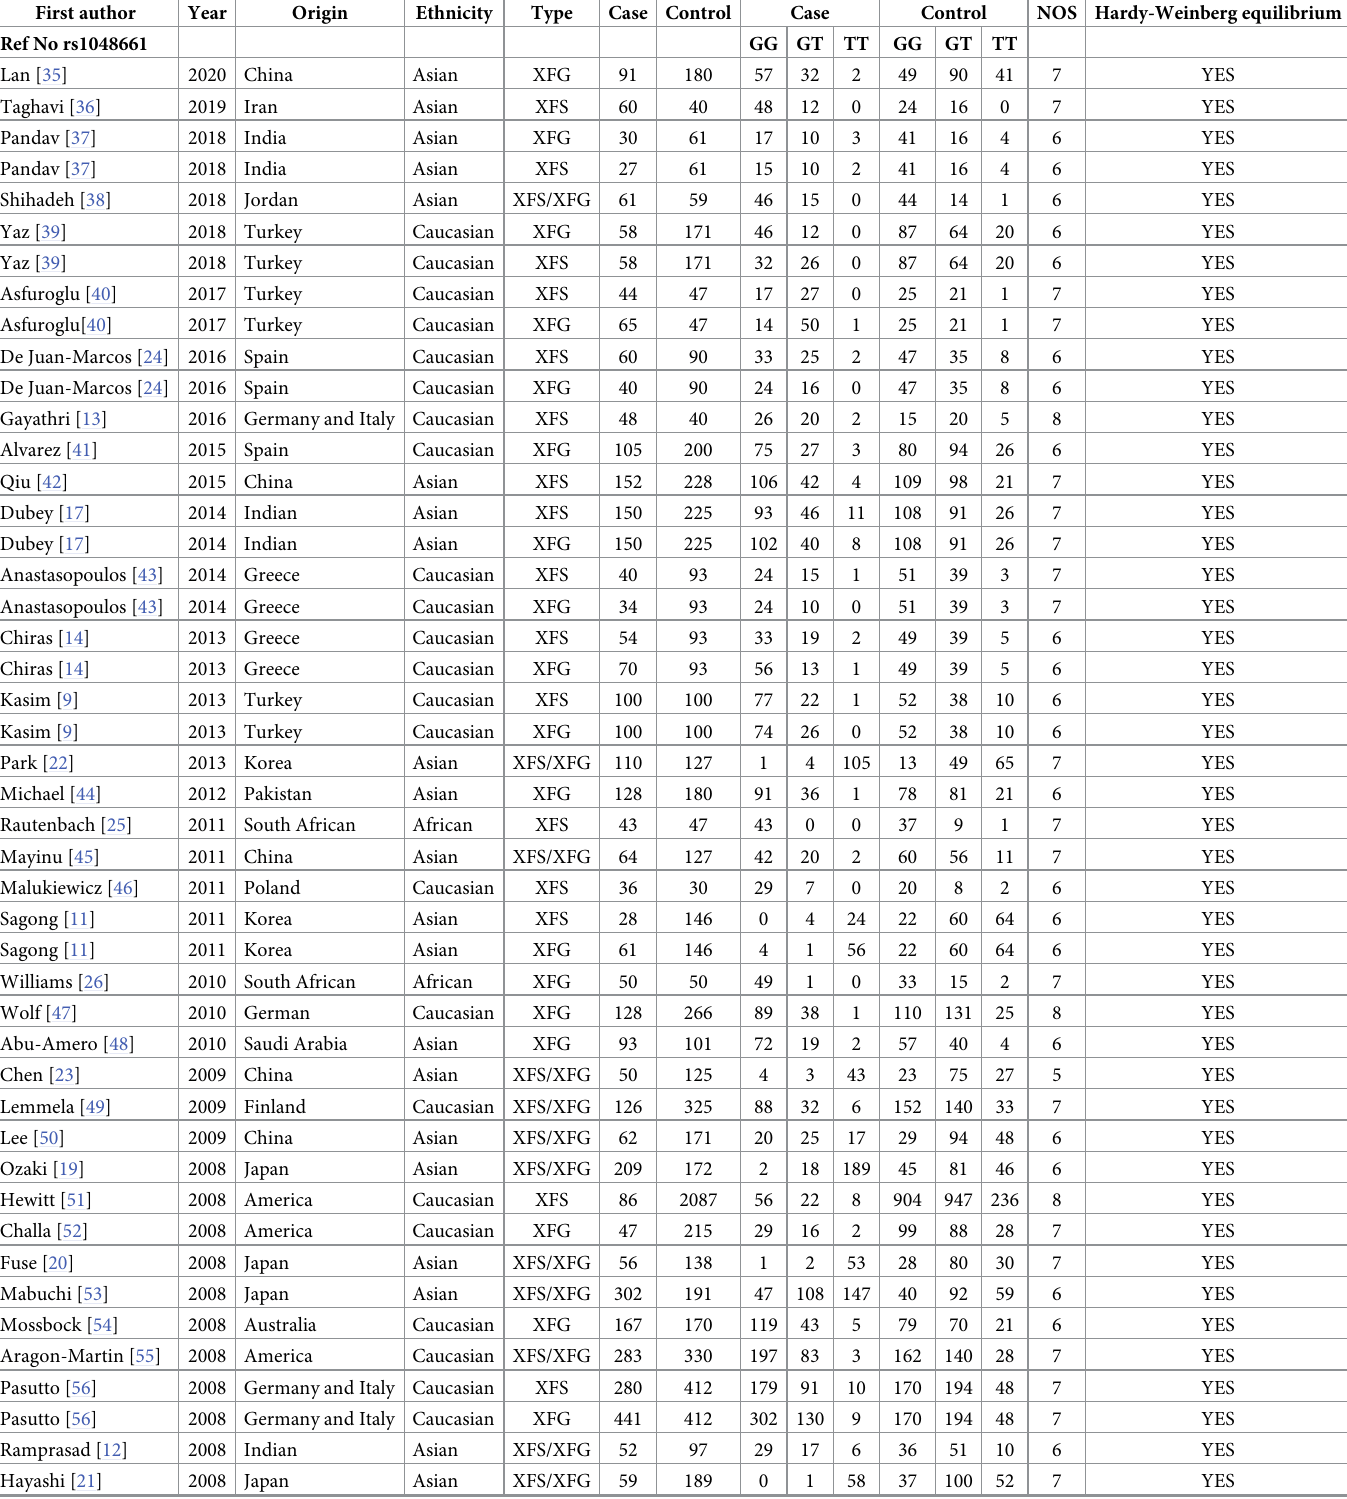
Table 1. Characteristics of case-control studies included in meta-analysis on LOXL1 gene polymorphism (rs1048661, rs2165241,